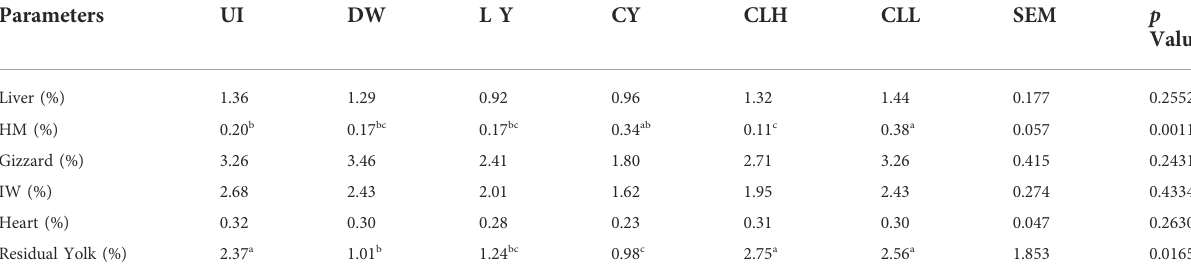
TABLE 2 Effect of in ovo cysteine and lysine on anatomical characteristics of day-old chicks.